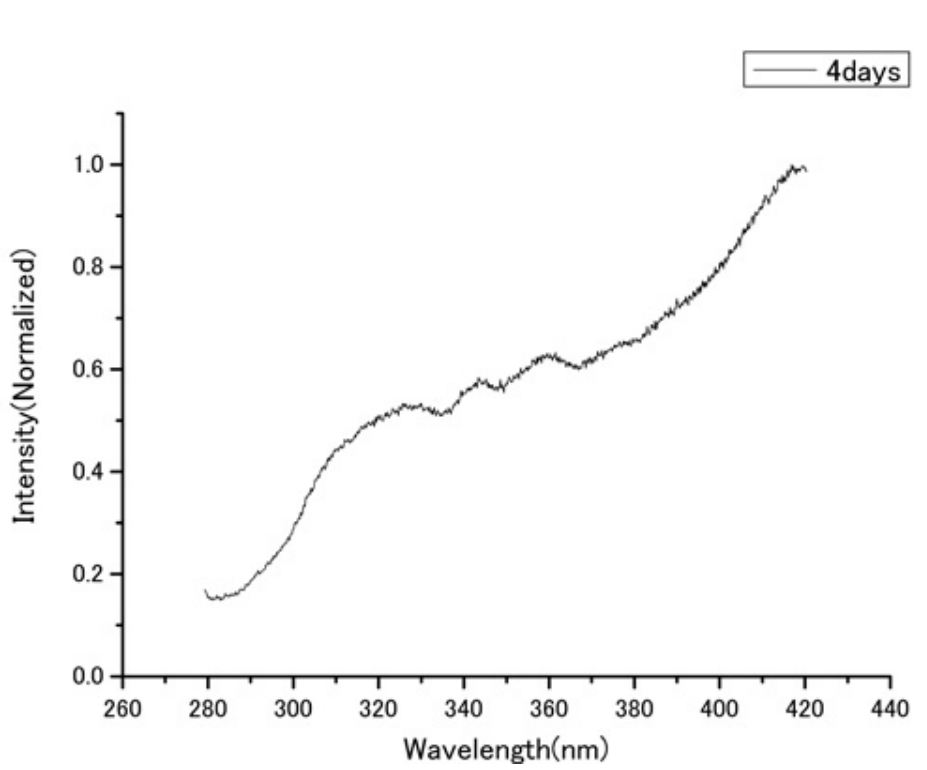
FIGURE 7 . Spectrum of peak A after 4 days. This spectrum was measured with 10-nsec delay